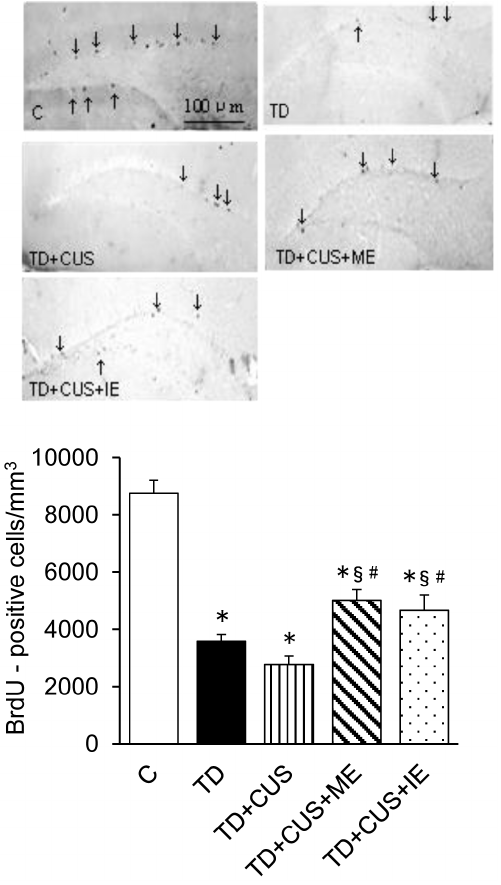
Figure 8. Effects of tryptophan deficiency, CUS and regular exercise on number of BrdU-positive cells in the dentate gyrus of the hippocampus. Data are expressed as mean 6 SEM. *, p , 0.05 vs. C; 1 , p , 0.05 vs. TD; # , p , 0.05 vs. TD +